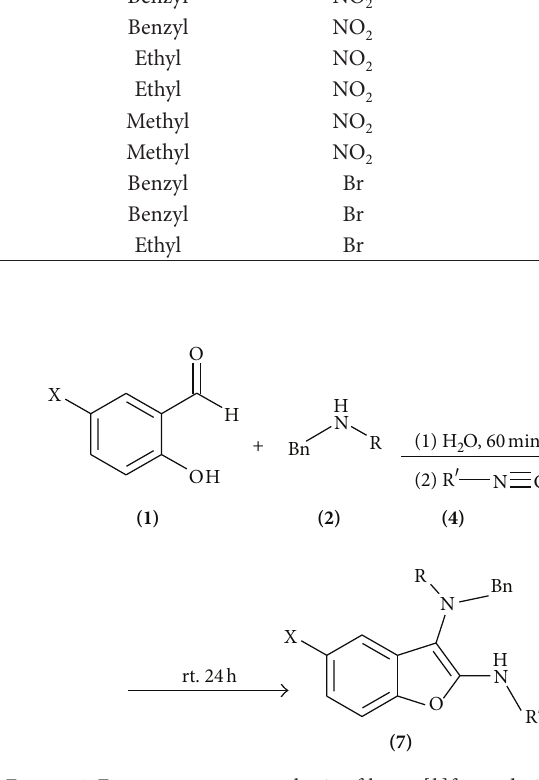
Figure 1: Four-component synthesis of benzo[ b ]furan derivatives, 7a–i , in